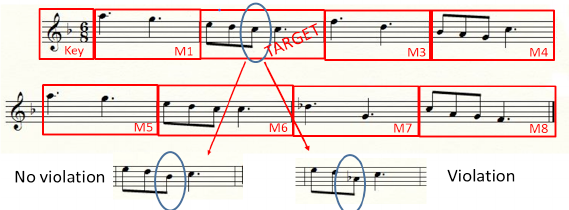
Figure 3. Example of AOIs designed for global analyses for a musical excerpt: key signature, Measure 1 (M1), Target measure (TARGET) with violation tone mode or no violation tone mode and Measure 3 to 8 (M3-M8). Thus, in this example the label of measure 2 is replaced by “TARGET” because that is the measure in which the modification occurred.